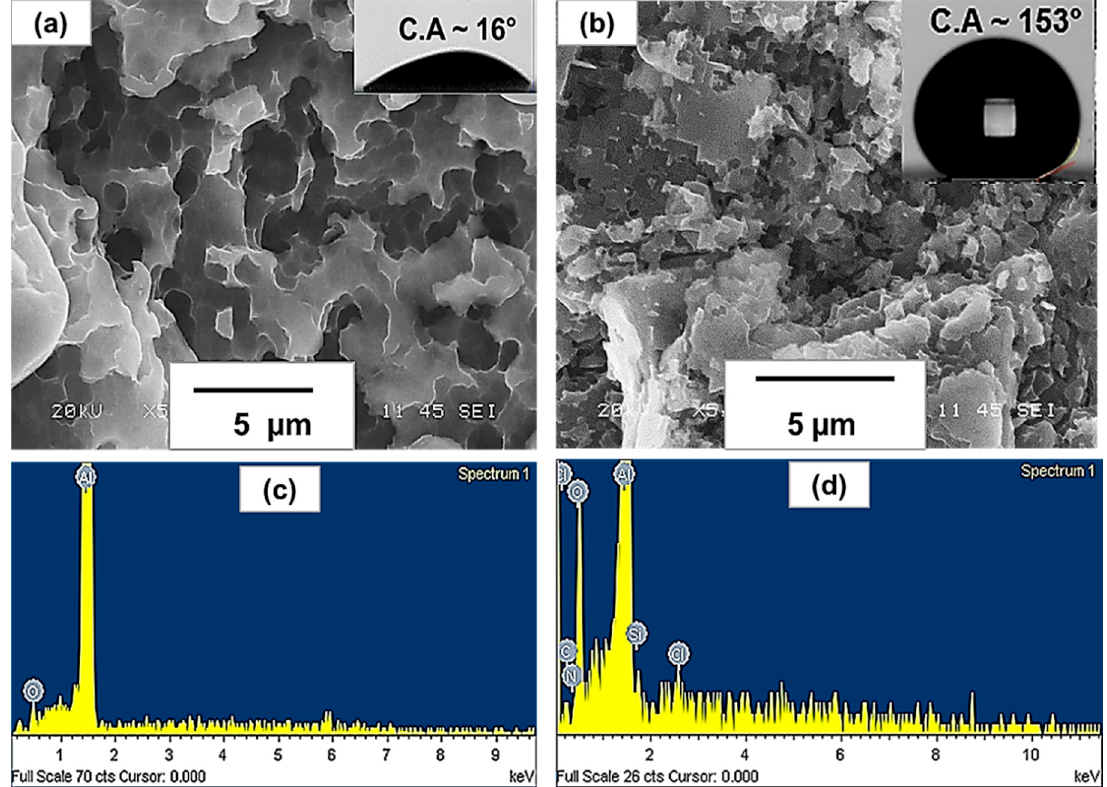
Figure 2. ( a – d ) SEM images and EDS spectra of etched Al substrate and OTES-QUATs / Al, respectively. The insets also show the images of water drop on the respective surfaces with their contact angles.